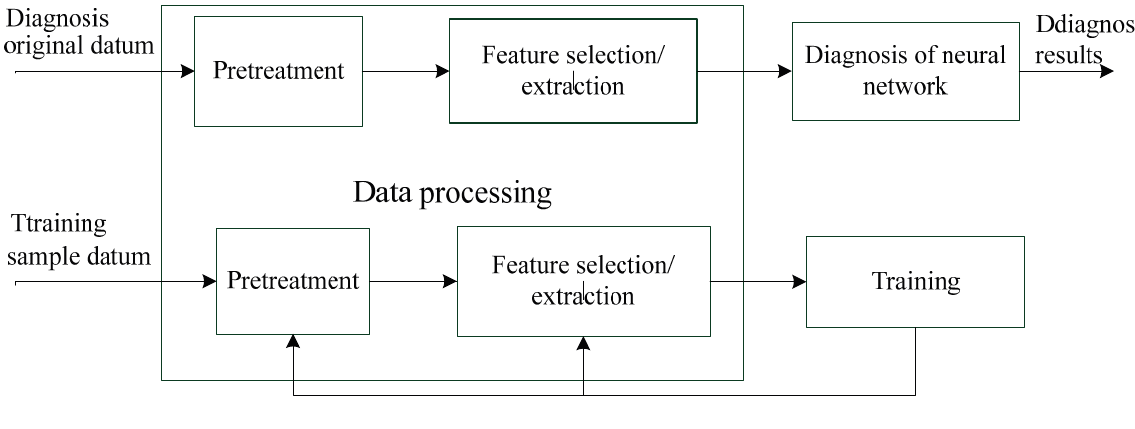
Figure 3. Structure of neural network fault diagnosis